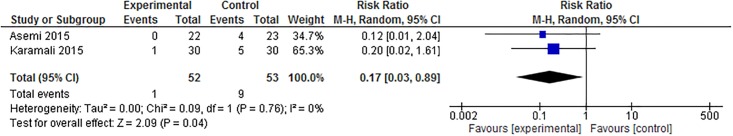
Meta- analysis of complications in the newborn (polyhydramnios).